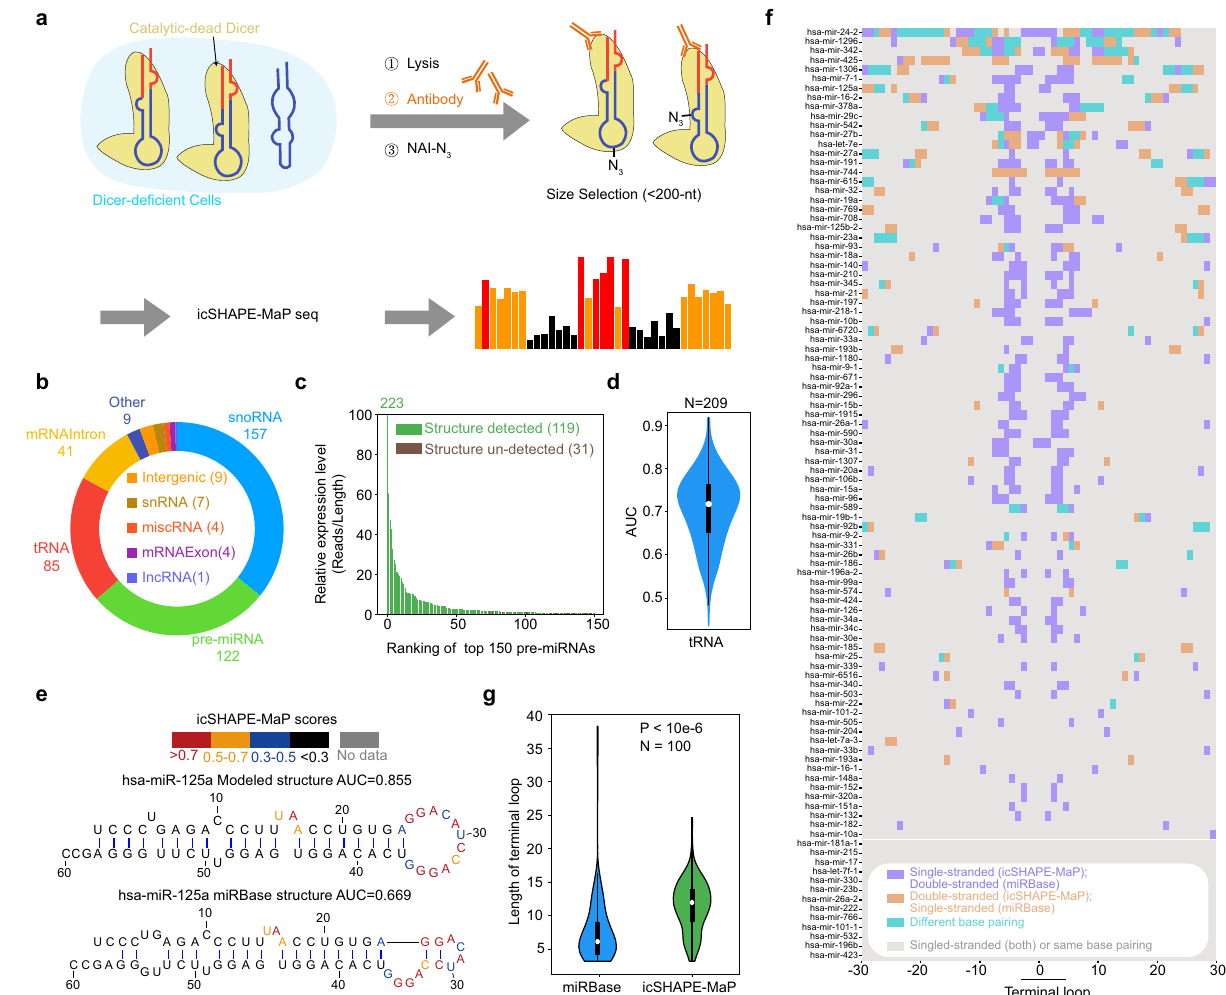
Fig. 2 RIP-icSHAPE-MaP captures the structural features of Dicer binding sites. a Flowchart of the RIP-icSHAPE-MaP protocol. b Ring diagram of the number of different types of Dicer-enriched RNAs in different colors with icSHAPE-MaP scores. c Bar plot of the relative expression level of the top 150 pre-miRNAs, calculated as the number of mapped reads divided by the RNA length. The green bars denote the pre-miRNAs with icSHAPE-MaP scores, and the brown bars indicate those without icSHAPE-MaP scores. d Violin plot of Area Under ROC Curves (AUCs) of icSHAPE-MaP scores for 209 tRNA secondary structures from the GtRNAdb database. e The secondary structure models and icSHAPE-MaP scores of hsa-miR-125a. The structure on the top was modeled using the RNAStructure software with icSHAPE-MaP scores as constraints; the structure on the bottom is from the miRBase database. f A Heatmap highlighting differences between secondary structure models of pre-miRNAs built with or without icSHAPE-MaP scores as constraints. Purple boxes indicate that these nucleotides are single-stranded in the experimentally inferred structures but are base-paired in the structures from the miRBase; orange boxes indicate the opposite. Cyan boxes indicate that these nucleotides are based paired in both structural models, but with different pairing counterparts. Gray boxes indicate those nucleotide positions with identical structures in both models, either single-stranded or base-paired with the same counterparts. g A violin plot showing the length distribution of the terminal loop for pre-miRNAs based on the structural models from miRBase prediction (blue) or icSHAPE-MaP (green). p Values were determined with a two-sided paired Student ’ s t test. Violin plots show the median (white circle), 25/75 percentiles, and the smallest/largest values within 1.5 times the interquartile range above/below quartiles. Source data are provided as a Source Data fi